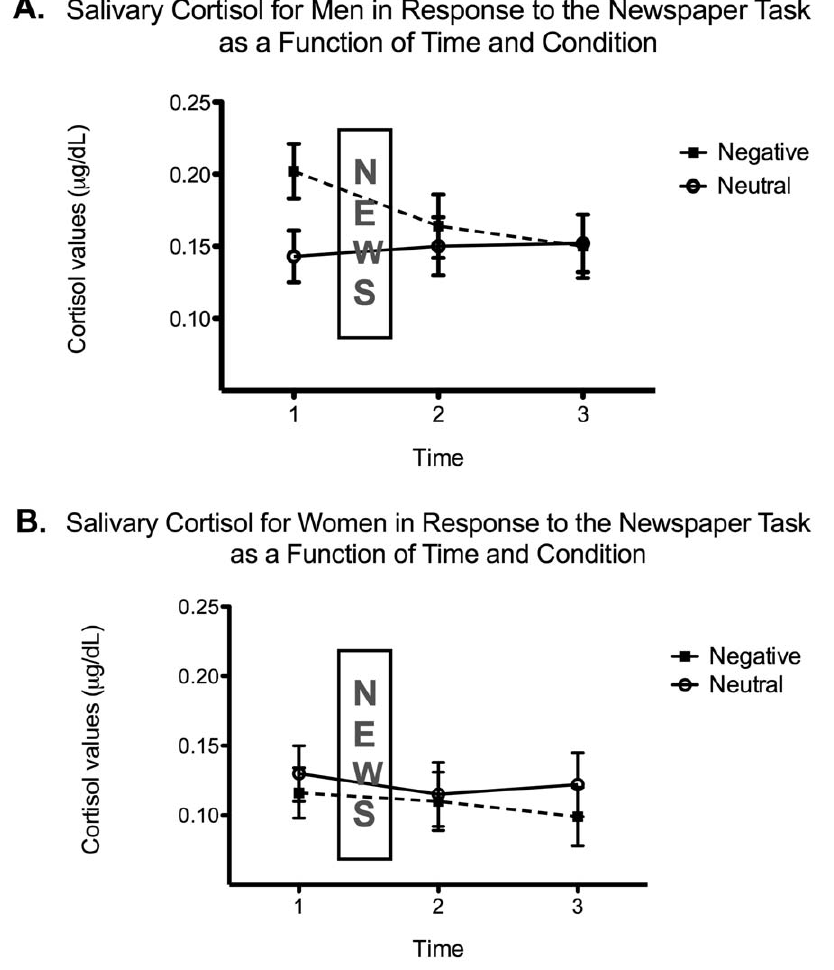
Figure 1. Mean salivary cortisol levels in response to the newspaper task as a function of Time (1– baseline, 2– immediately following the newspaper task, 3– ten minutes after the end of the newspaper task) and Condition (neutral, negative) for men (panel A) and women (panel B). Adjusted means as a function of ‘emotionality’ and ‘concerned’ are presented. The error bars represent the standard error of the mean.